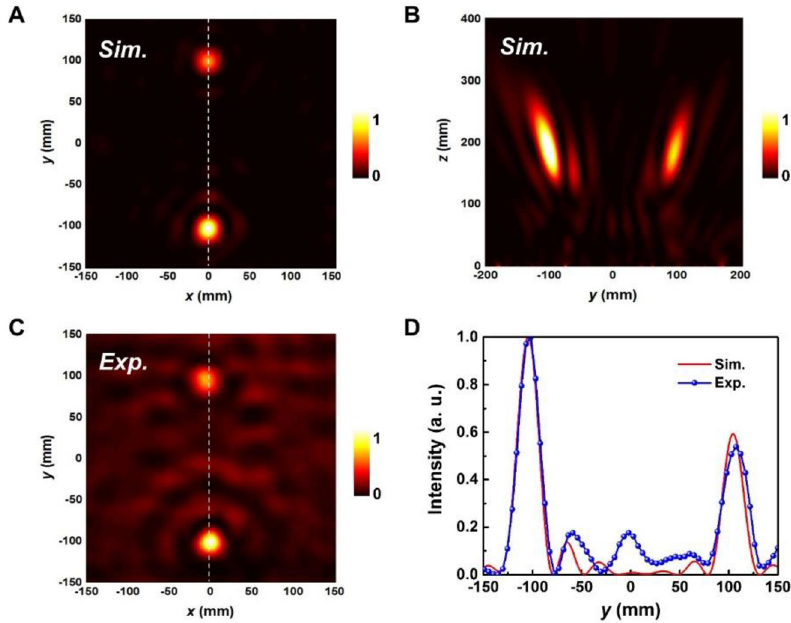
Figure 7: The simulated normalized power distributionsof E - fi eldin(A)focalplaneand (B) yoz plane for RCP incidence. (C) The measured normalized power distribution of E - fi eld in focal plane. (D) The simulated and measured power scanned along the line ( x = 0 mm) shown in Figure 7A and